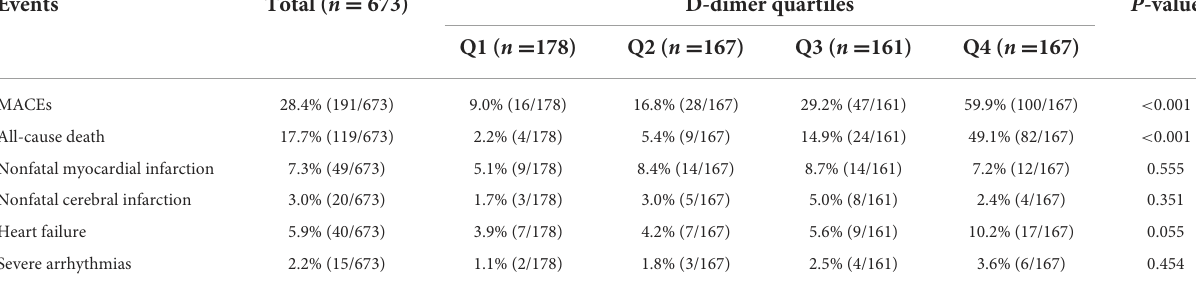
TABLE 3 Clinical outcomes during the follow-up period.